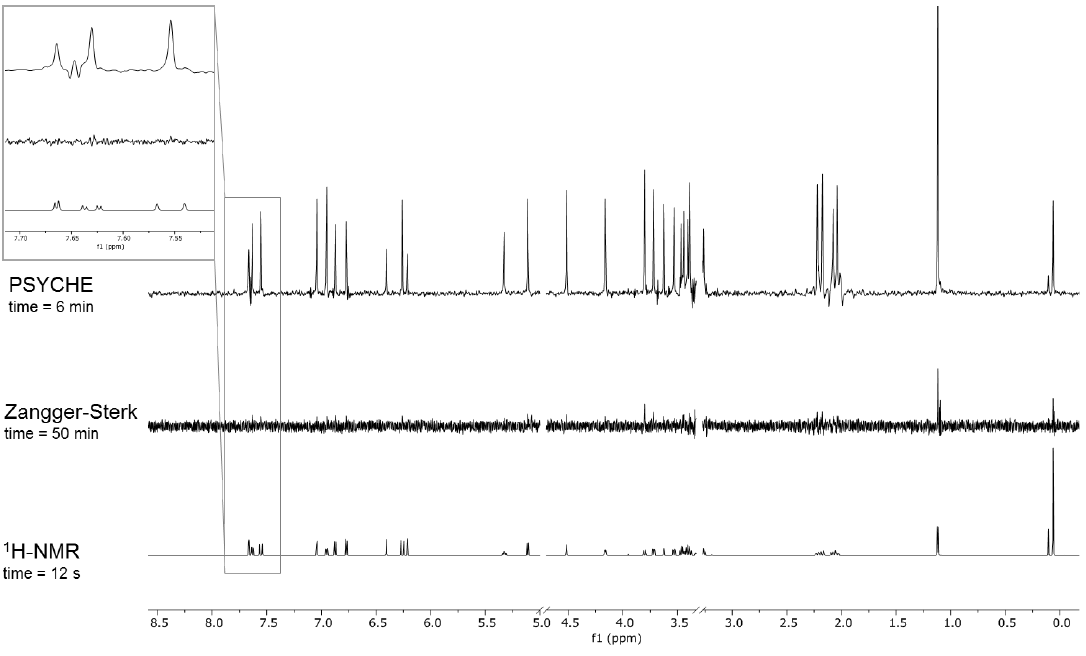
Figure 1. Comparison of the 1 H-NMR, Zangger–Sterk (PSD1 [19]) and PSYCHE [32] spectra acquired with the default parameter settings (number of scans = 4).